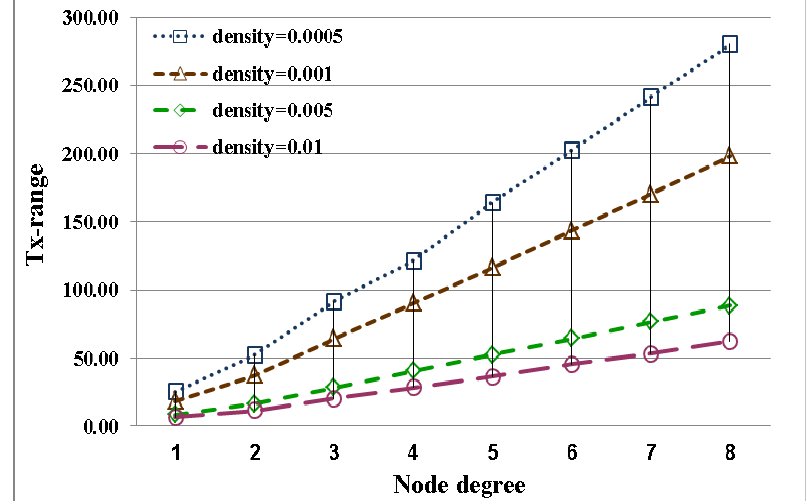
Figure 9. A comparison of simulation results for the transmission range with node degrees ranging from 1 to 8 with different node densities.